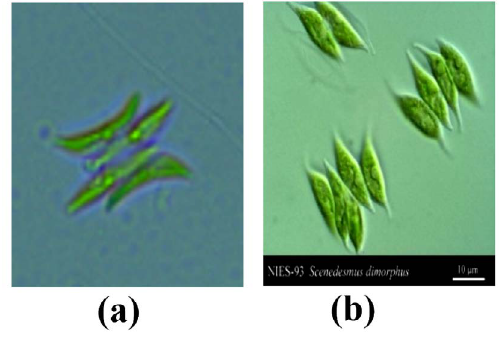
Fig. 1. Microalgae morphology (a) MA1 Isolate, (b) Scenedesmus dimorphus photo from